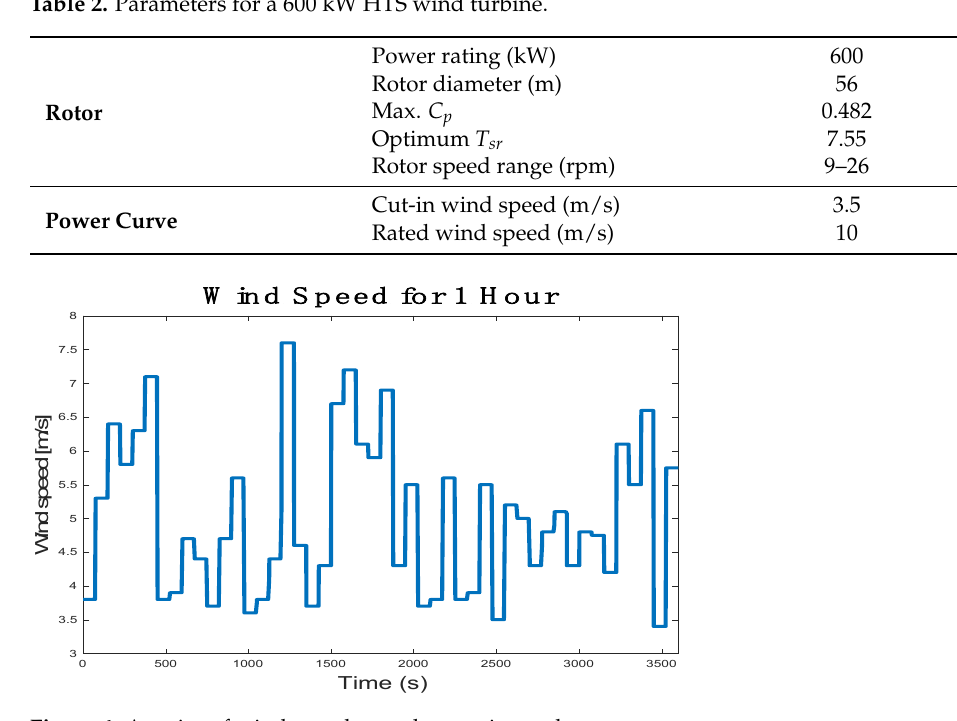
Figure 5. Output power difference at different (cid:3080) (cid:3118)